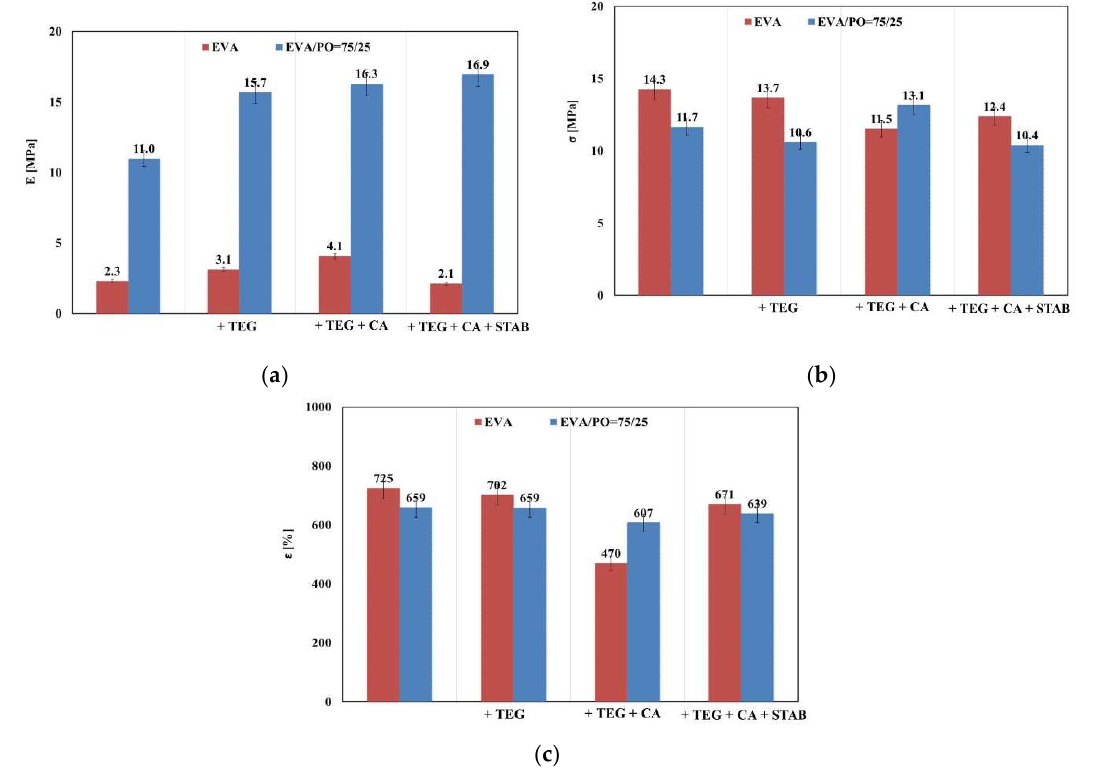
Figure 2. Main mechanical properties. ( a ) Elastic modulus, E; ( b ) tensile strength, σ; ( c ) elongation at break, ε of the EVA and EVA/PO = 75/25 wt.% samples with and without an adhesion promoter (TEG), a crosslinking agent (CA) and stabilizers (STAB).